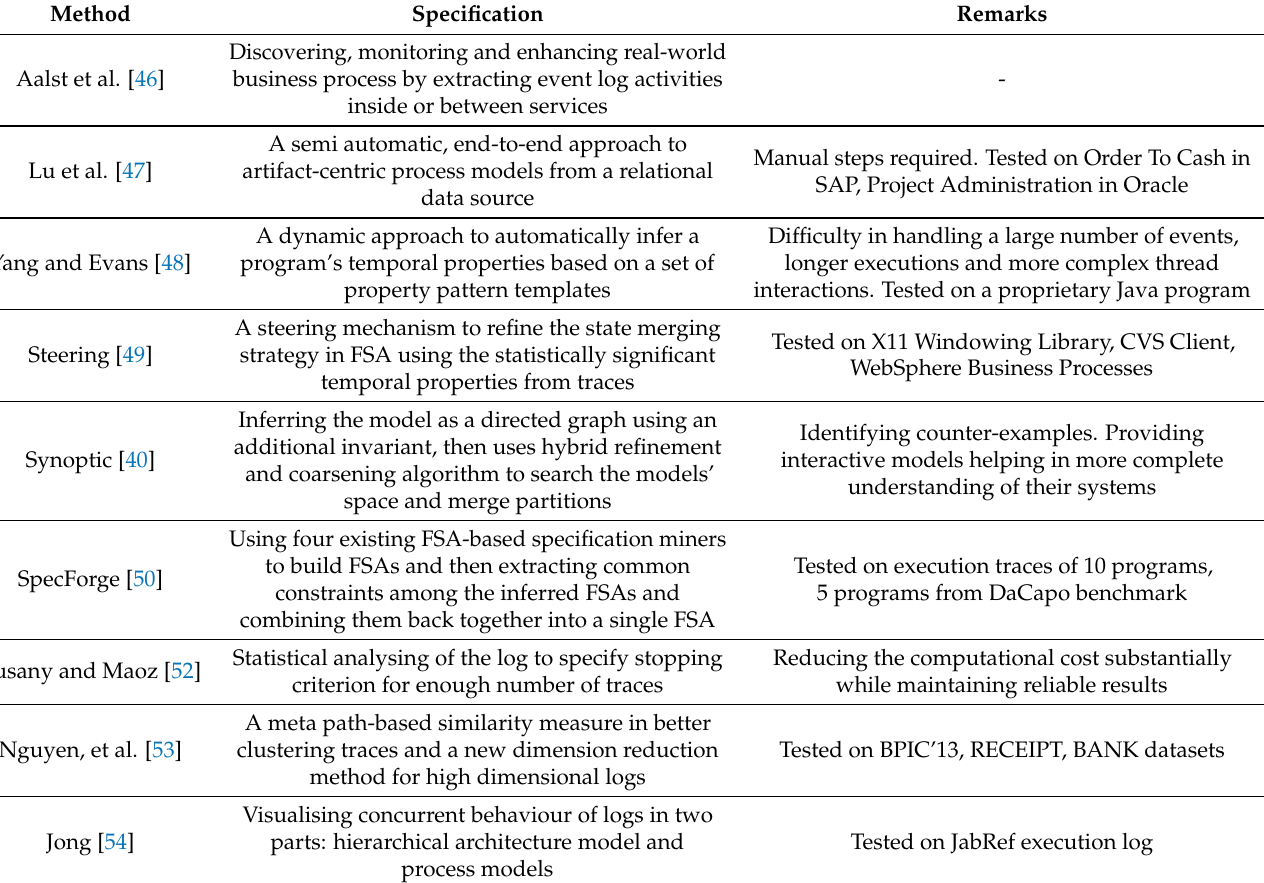
Table 4. Different approaches of inferring control models from program internal interactions logs.